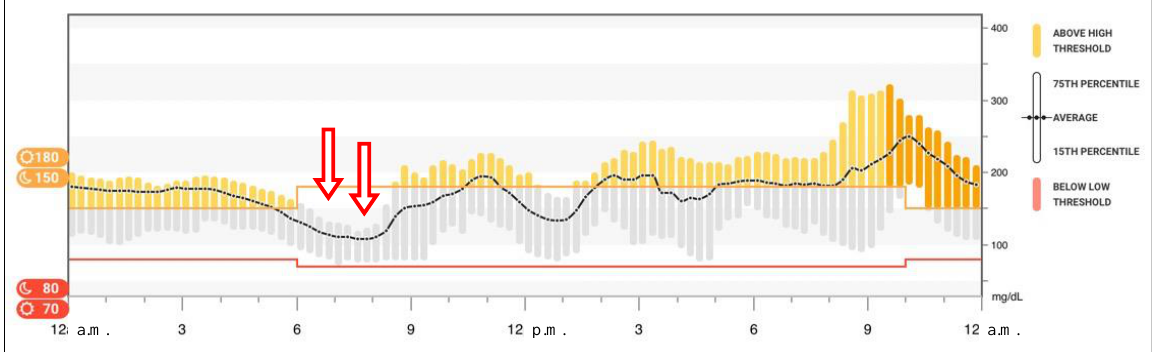
Figure 1. Glucose data reproduced from Dexcom ® CGM Clarity software (Dexcom, Inc., San Diego, CA, USA), the graph shows the glucose trend averaged over 14 days. Arrows indicate the sudden switch from hyperglycemia to hypoglycemia near dawn.